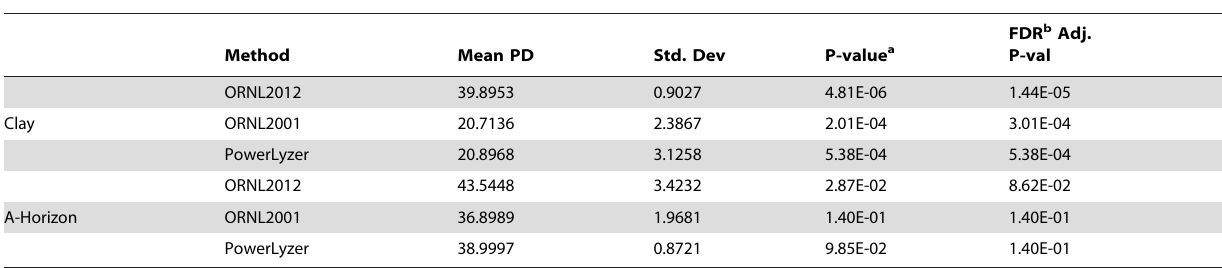
Table 2. Phylodiversity by Extraction Method.